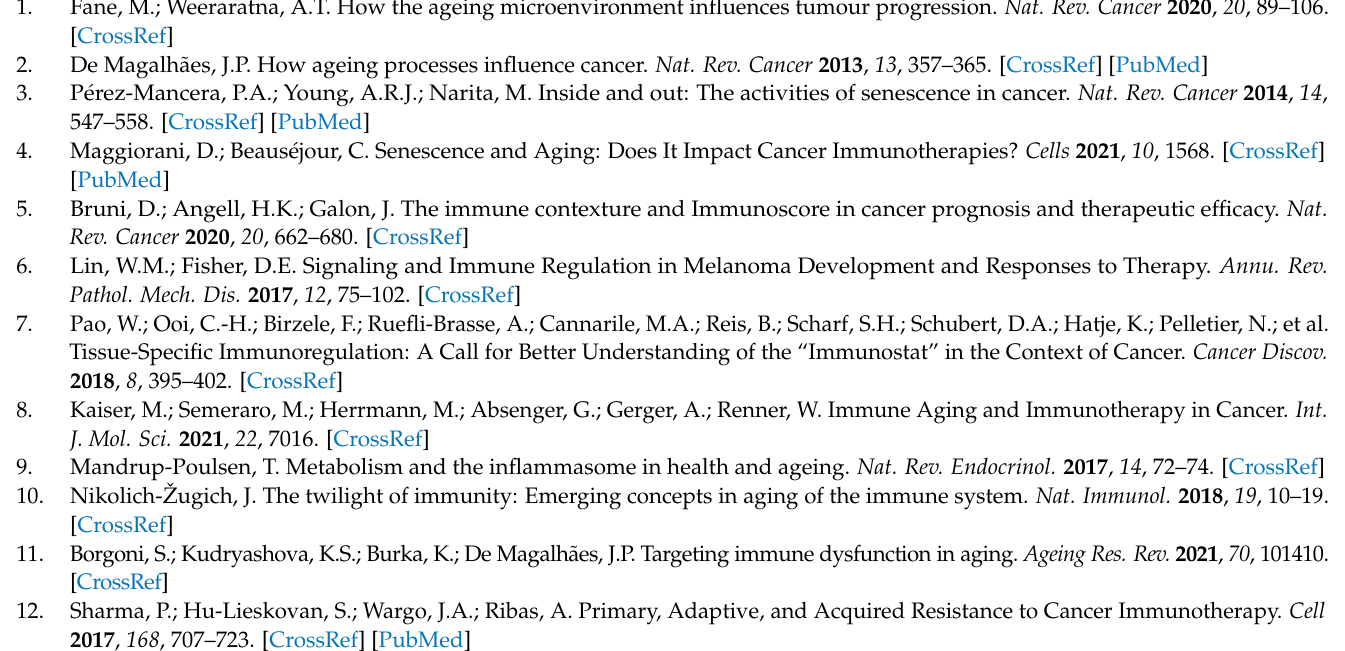
Table S1. Dysregulated IRPs in tumor across 25 cancer types. Table S2. Dysregulated IRPs with age across 25 cancer types. Table S3. Validation of the significant relations between IRPs and age. Table S4. Correlation between IRPs and ARGs using Pearson, Spearman and Mutual information analysis. Table S5. Cancer-specific results of correlations between IRPs and ARGs. Table S6. Top 1% ranked genes across 25 cancers. Table S7. Drug prediction of top 1% genes in pan-cancer. Table S8. Dataset sources and sample size statistics. Table S9. Details of cancer cell lines from CCLE database. Table S10. Details of Immport genesets. Table S11. Datasets used for ICB response